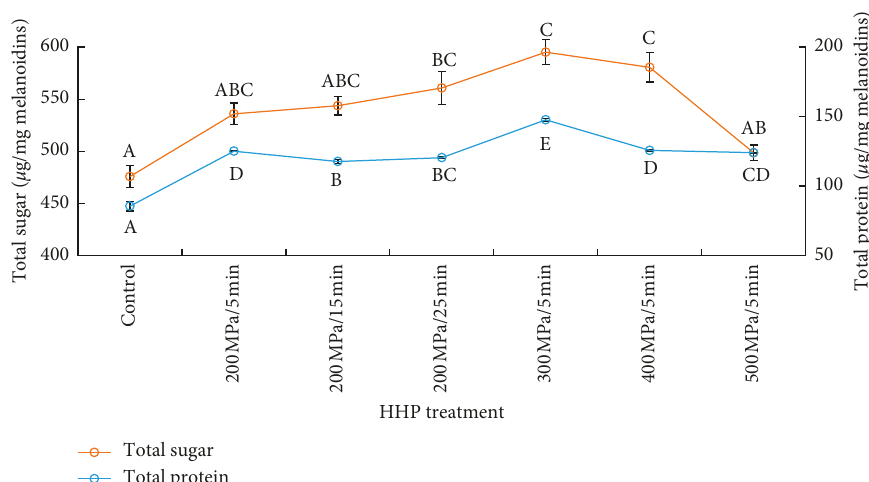
Figure 1: Total sugar and total protein contents in melanoidins after different HHP treatments. Different uppercase letters in the same line indicate significant differences at the P < 0 . 05